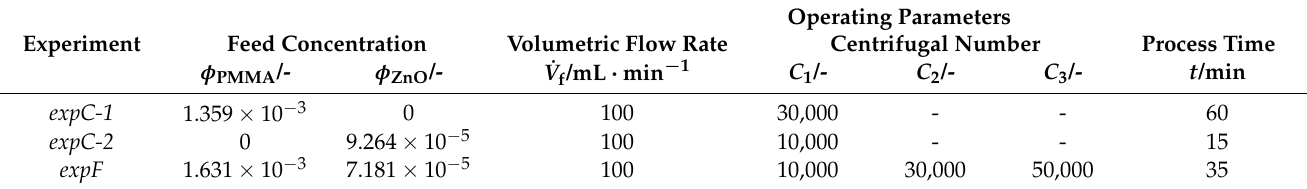
Table 1. Listed information on feed suspensions and operating